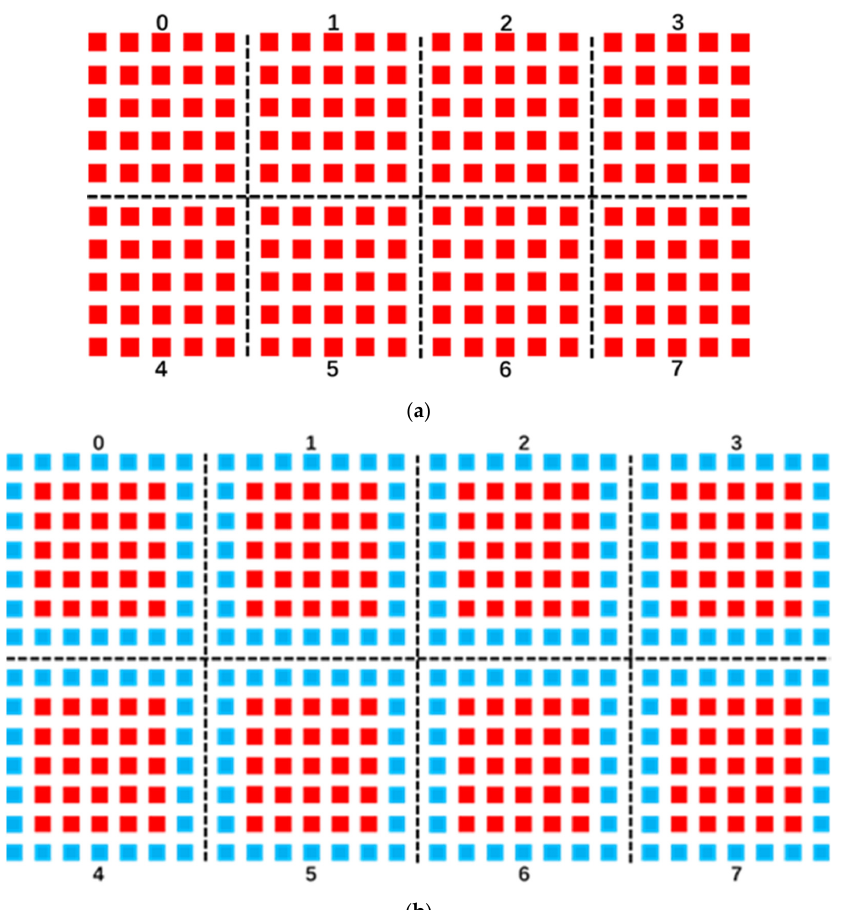
Figure 3. The decomposed domain of LBM parallelism. (The whole computational area is decom- posed into 4 × 2 domains. The numbers in the figure are the serial number of the decomposition region, and the red and blue, respectively, correspond to the real lattice and the virtual lattice). ( a ) Domain decomposition schematic; ( b ) Domain decomposition with virtual lattice in the boundaries.